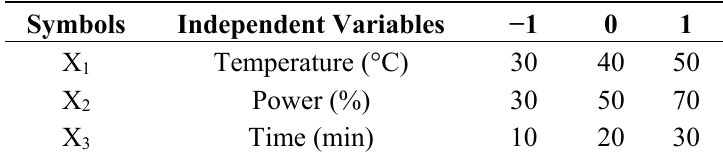
Table 4. Independent variables, symbols and levels used in this Box-Behnken